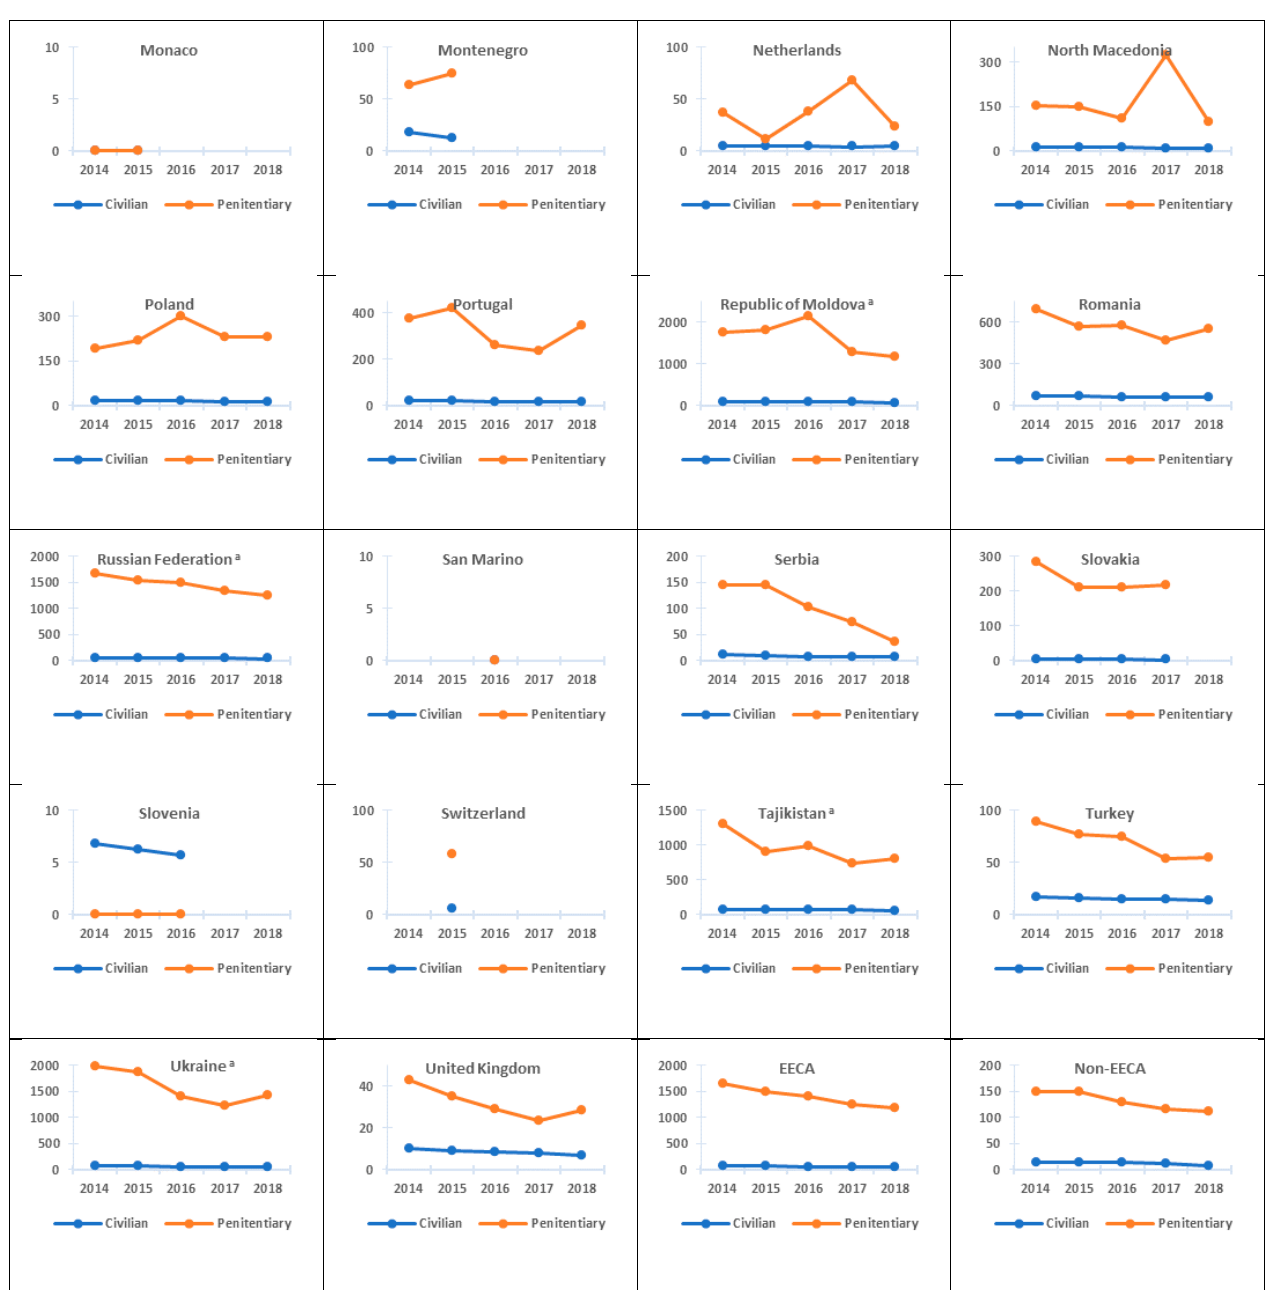
Figure 3. Trends in TB notification rates in the civilian and penitentiary sectors, WHO European Region, 2014–2018. TB: tuberculosis; WHO: World Health Organization. a EECA country. Note: TB notification rate: number of new and relapse tuberculosis cases registered and reported per 100,000 population.